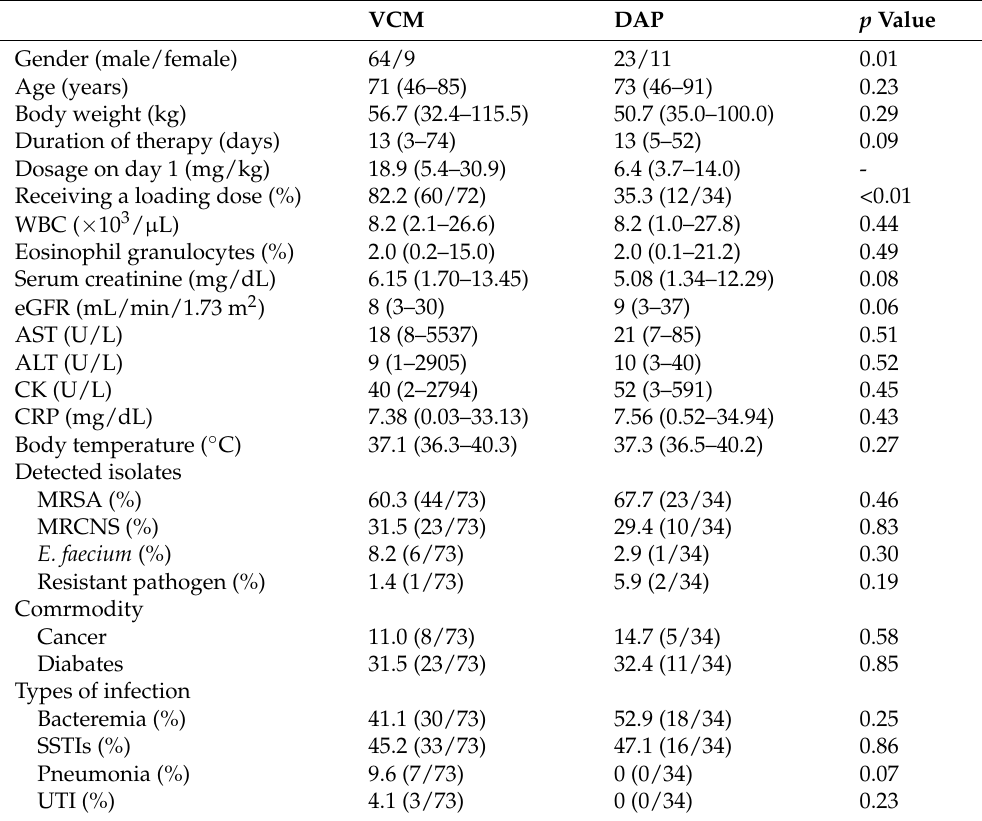
Table 1. Clinical characteristics of the registered